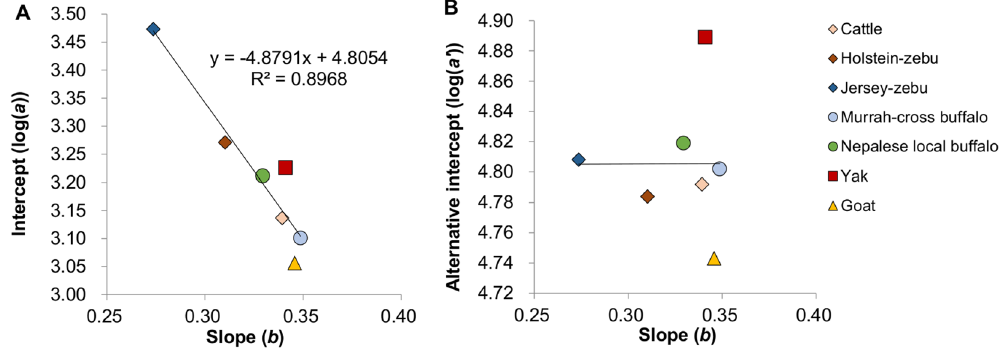
Figure 3. Scatter plots of allometric parameters across species and breeds. ( A ) Slopes ( b ) and intercepts (log( a )). ( B ) Slopes and alternative intercepts (log( a’